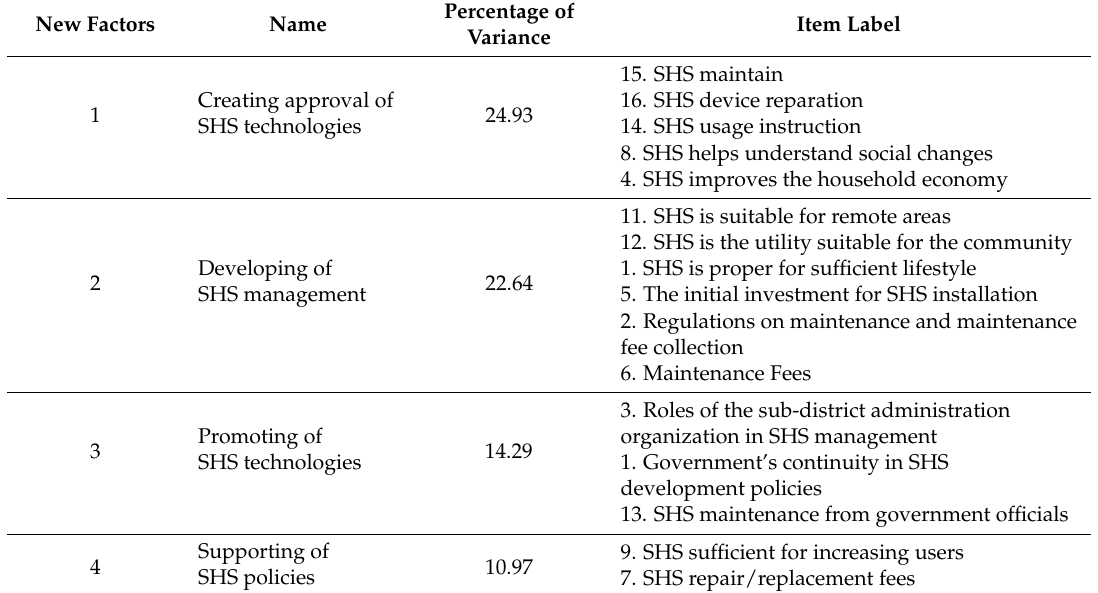
Table 6. Name of new factors with the percentage of